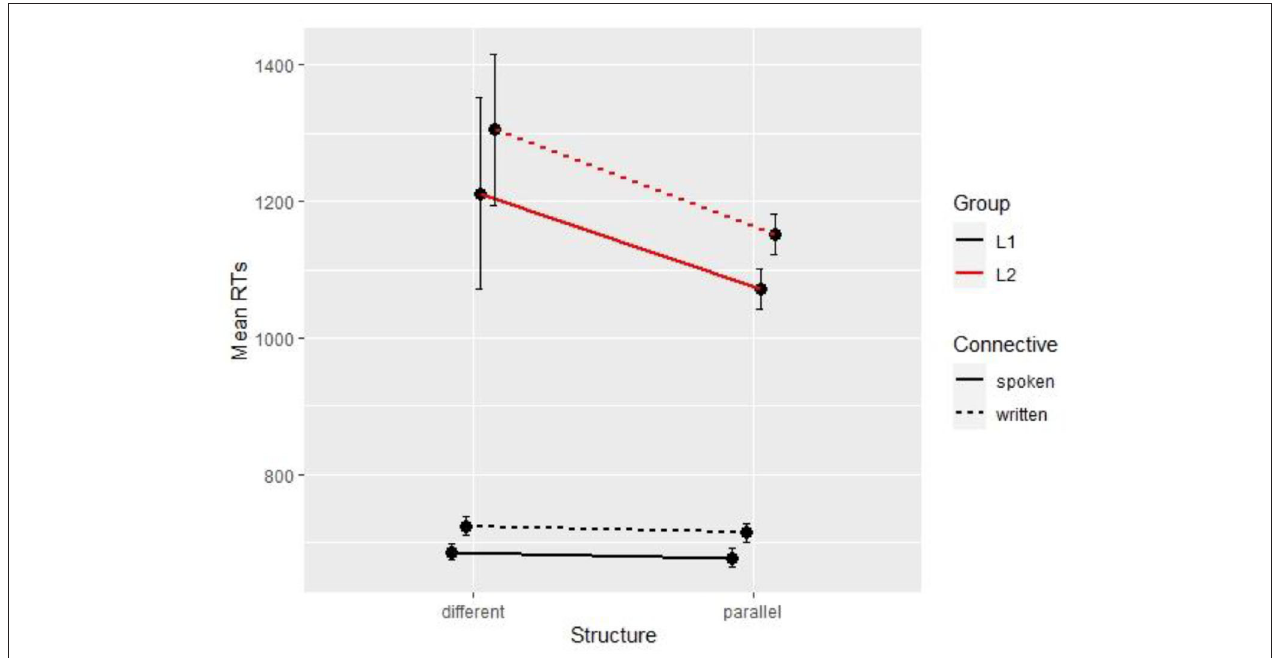
FIGURE 2 | Mean reading times per condition and per group (Experiment 2, segment 4).